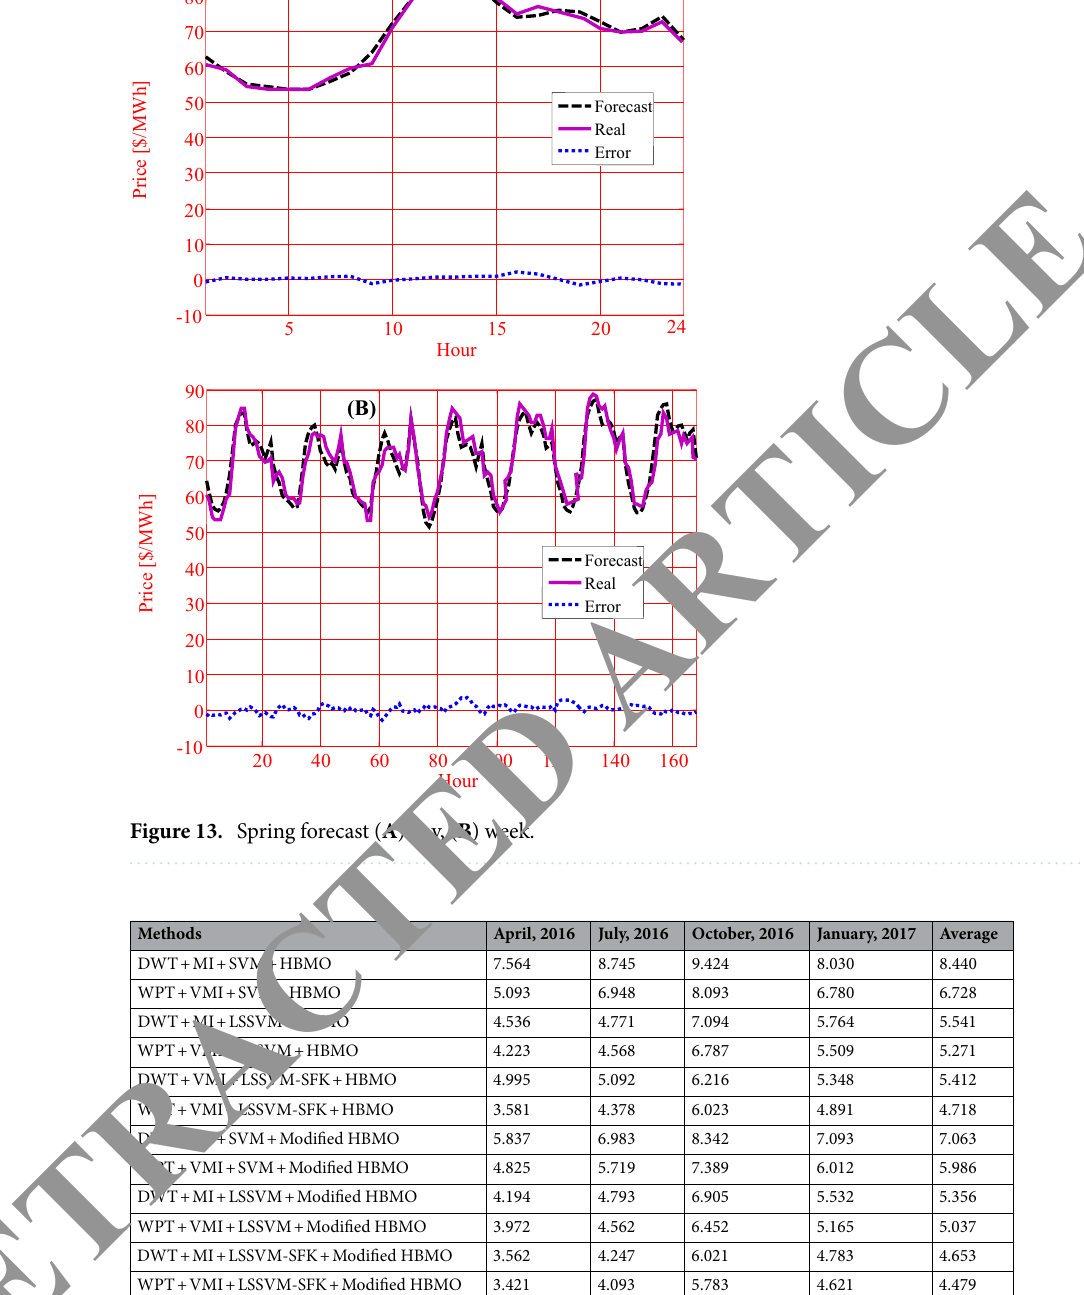
Figure 13. Spring forecast ( A ) day, ( B ) week.